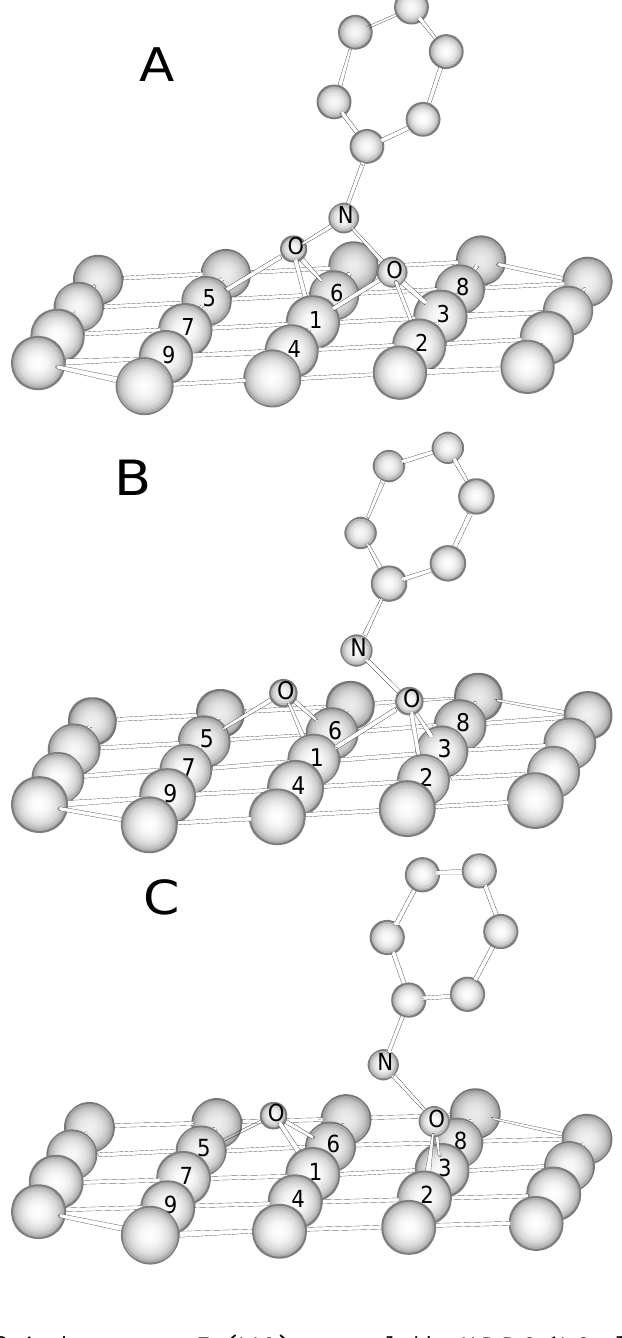
Figure 3. Adsorption of nitrobenzene on Fe(110) as revealed by NDDO/MC cluster calculations. The only top layer of the cluster is shown for